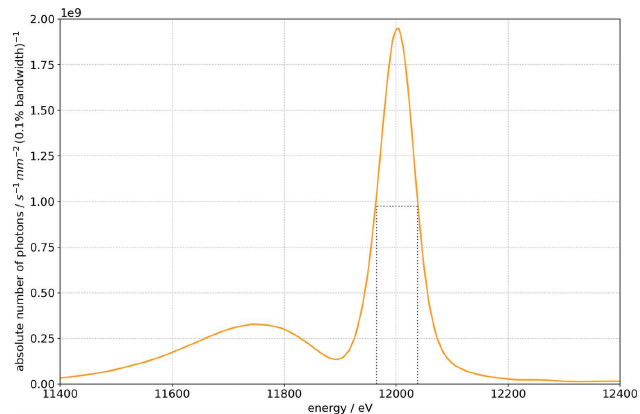
Table 2 Key photon flux and bandwidth parameters for the different experi- mental conditions.